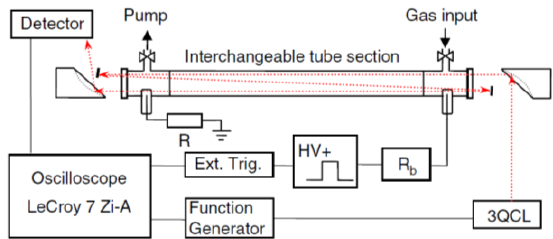
Figure 8. Experimental set-up used to study surface vibrational relaxation of N 2 [52], © IOP Publishing. Reproduced with permission. All rights reserved.